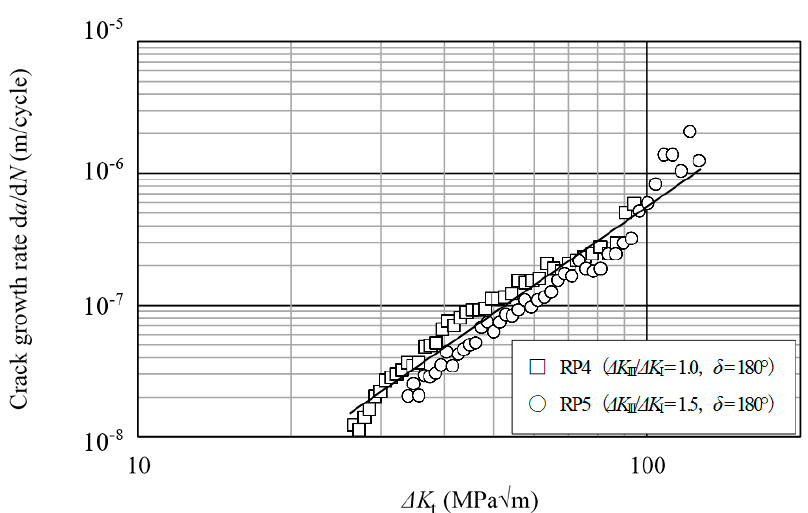
Figure 10. Branch crack growth rates against ∆ K t for RP.